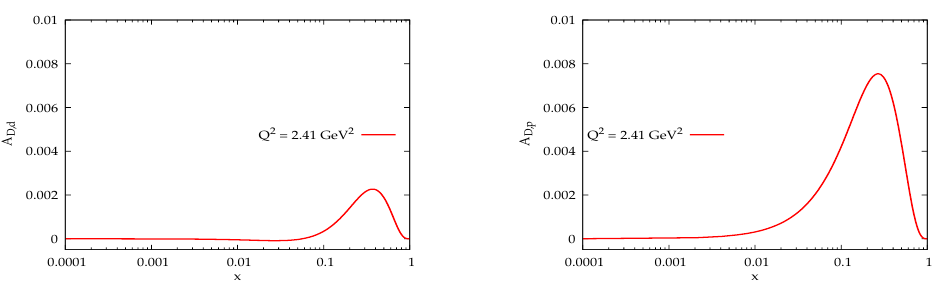
Figure 1: [ 11 ] We plot the difference asymmetries (a) A (b) A (proton target) vs. x at Q 2 = 2.41 GeV 2 . We integrate the variables z and D , p P over the ranges 0.1 < z < 1 and 0 < P T